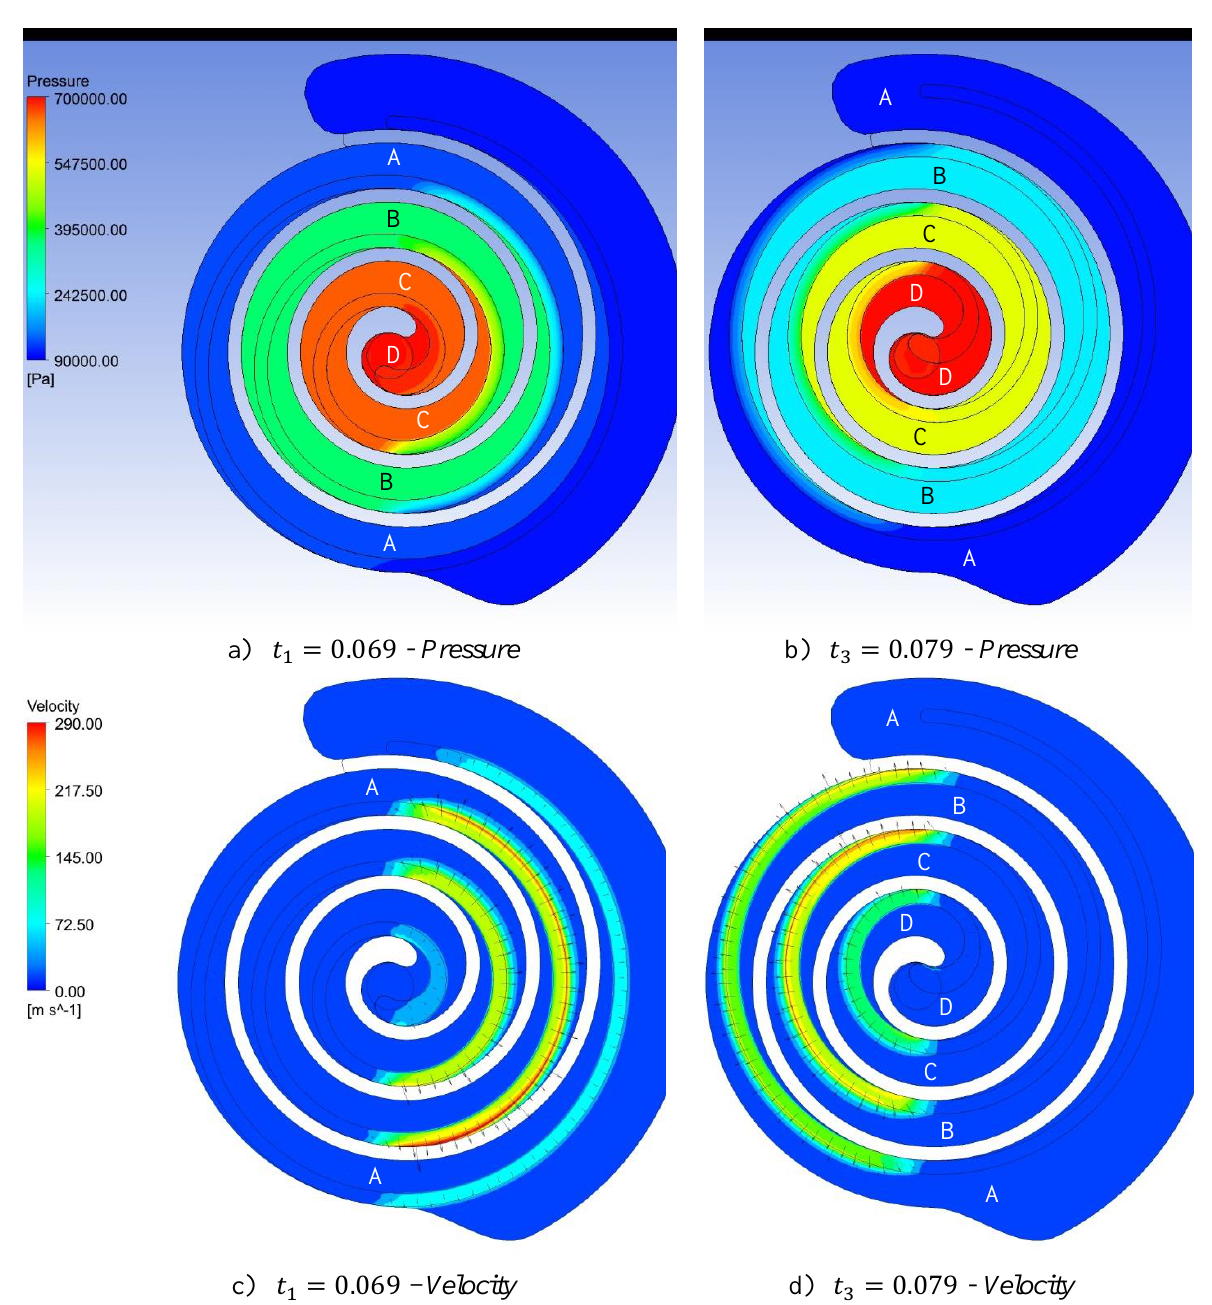
Figure 20. Contour plot of the pressure and of the velocity in a section plan normal to the scroll axis and passing through the axial gap. Comparison between two different instants: t 1 (0.069) and t 3 (0.079).